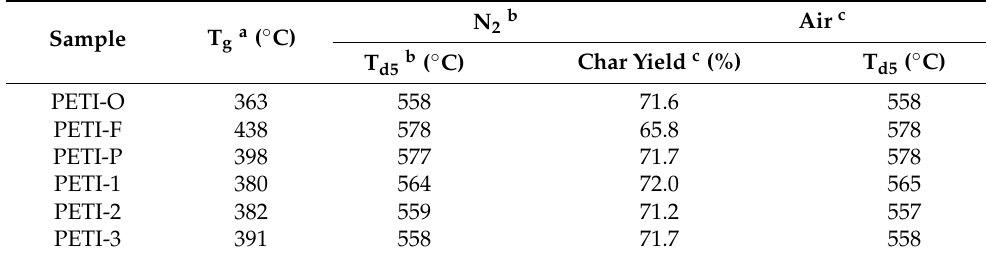
Table 7. Thermal properties of the thermal-cured polyimides cured at 380 ◦ C for 2 h.